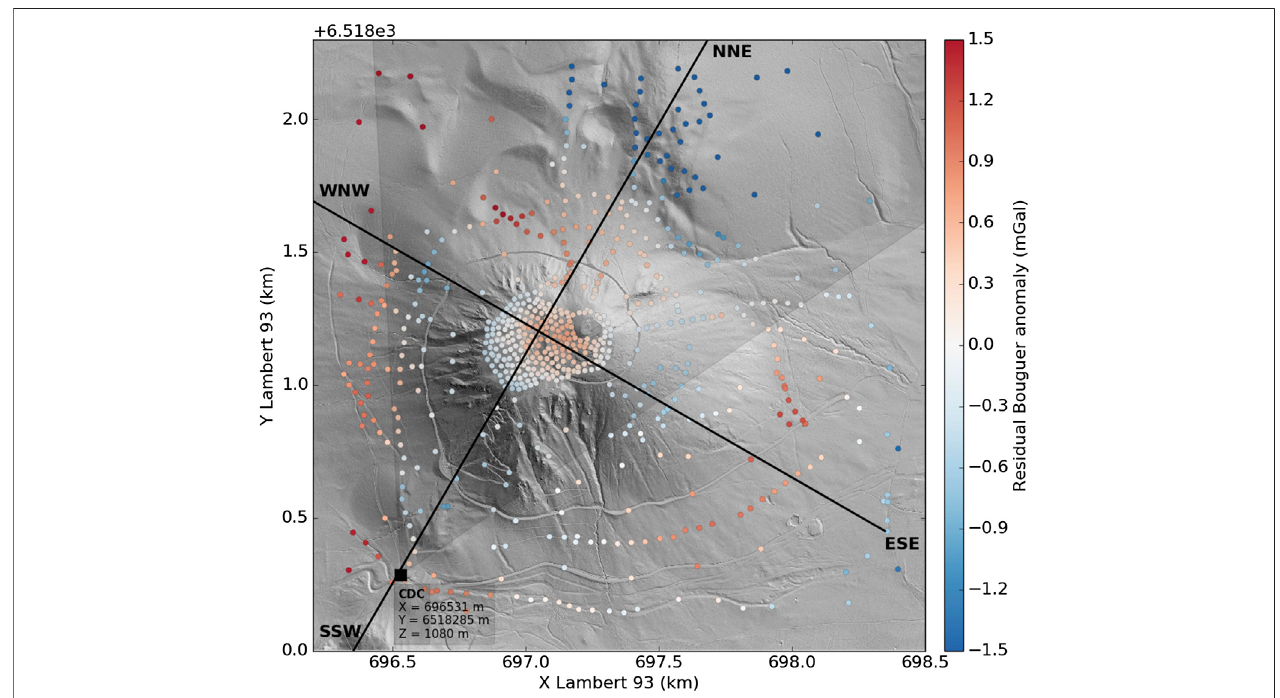
FIGURE 2 | Residual Bouguer anomaly data of the Puy de D ˆ ome volcano using correction densities of 2,670 kg/m 3 (far- fi eld), 2,420 kg/m 3 (mid- fi eld) and 1,890 kg/m 3 (near- fi eld). Thegravimetric measurements are fromPortalet al.(2016).The extent ofthismap isindicated byablue square in Figure1 . Thelocationofthe muon detector installed at theCol de Ceyssat (CDC)isindicated(blacksquare)aswellas theangle of viewofthe detector (grayshaded area). The twoblacklineslocate the slices of the inversion results shown in Figures 6 , 7 .